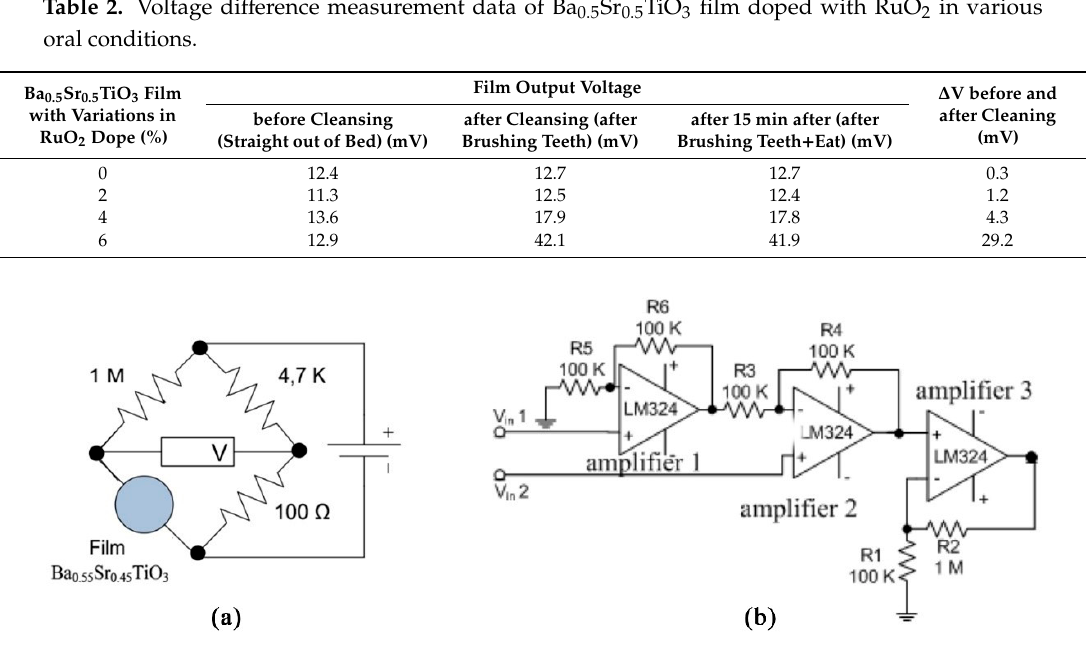
Figure 8. ( a ) The Wheatstone circuit; ( b ) The op-amp